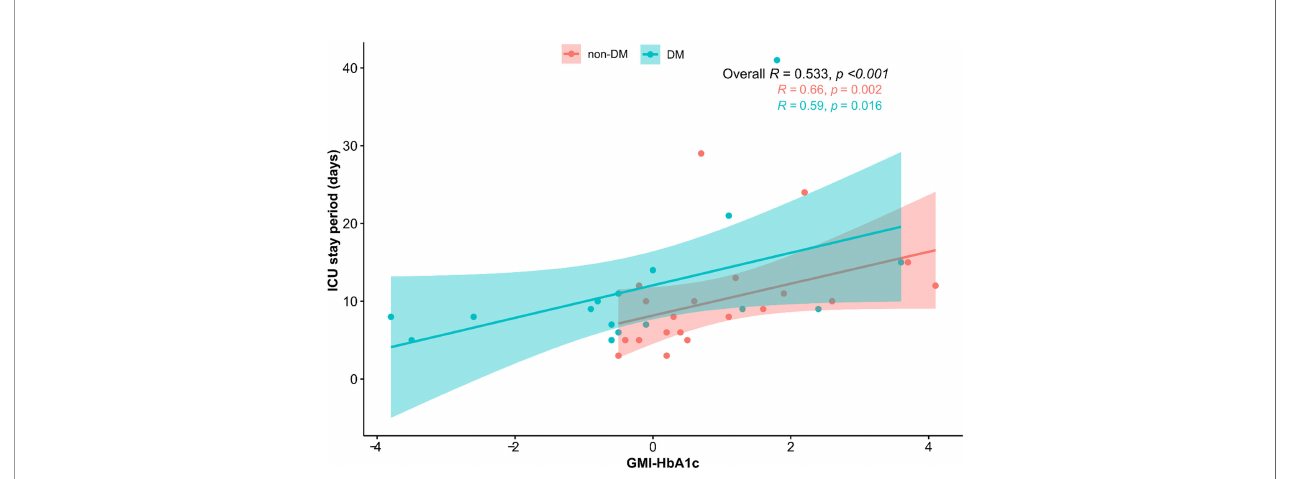
FIGURE 1 | Scatter plot of the relationship between GMI-HbA1c and ICU stay. The correlation coef fi cients are presented as Spearman ’